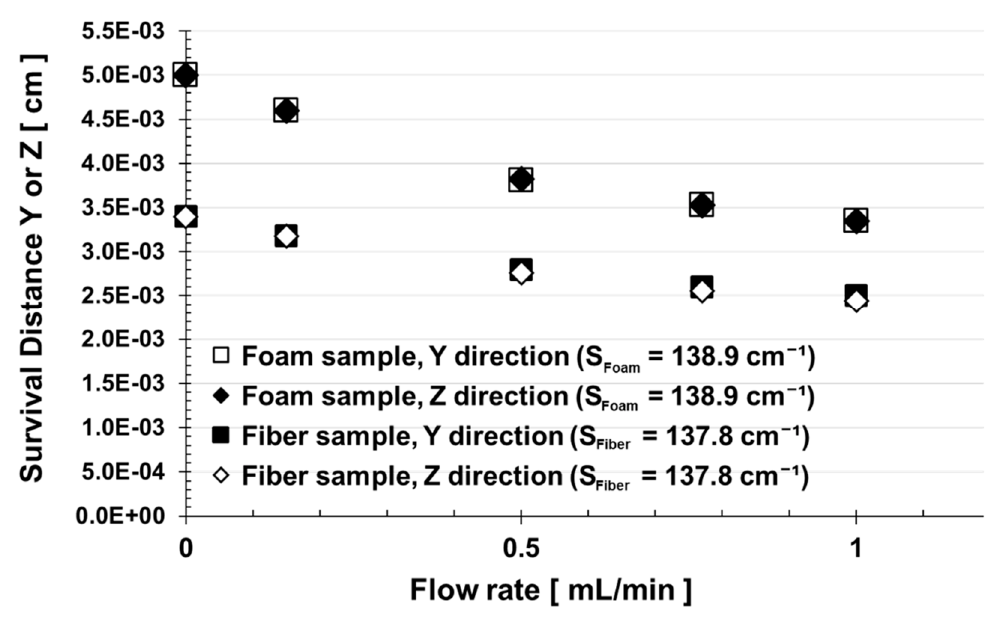
Figure 4. Survival distances in the Y & Z directions, as a function of the scaffold geometry and perfusion flow rate. Data is plotted for the limiting case of the fully reactive rLST particles. Both scaffolds types are chosen to have a similar specific surface area.